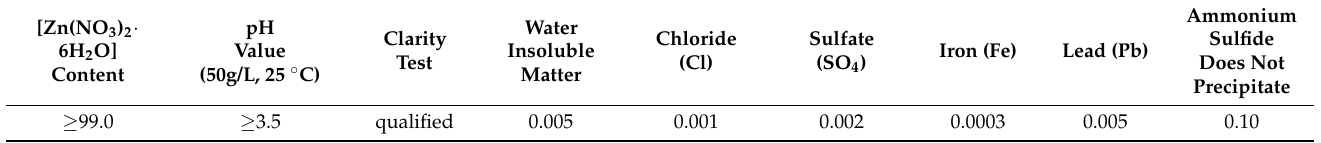
Table 2. Technical conditions of zinc nitrate hexahydrate (Zn(NO 3 ) 2 · 6H 2 O) (analytical purity) (unit: